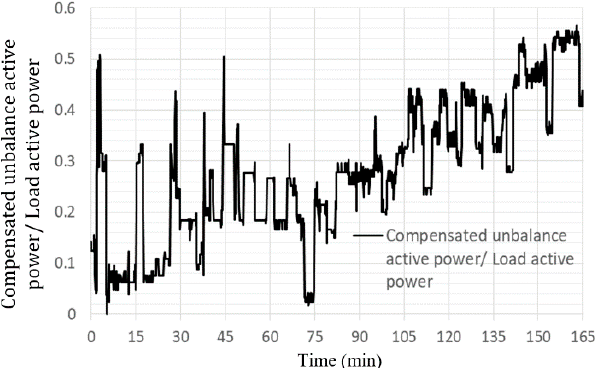
Figure 24. Evolution of the compensated unbalance active power during the recordings (p.u.).